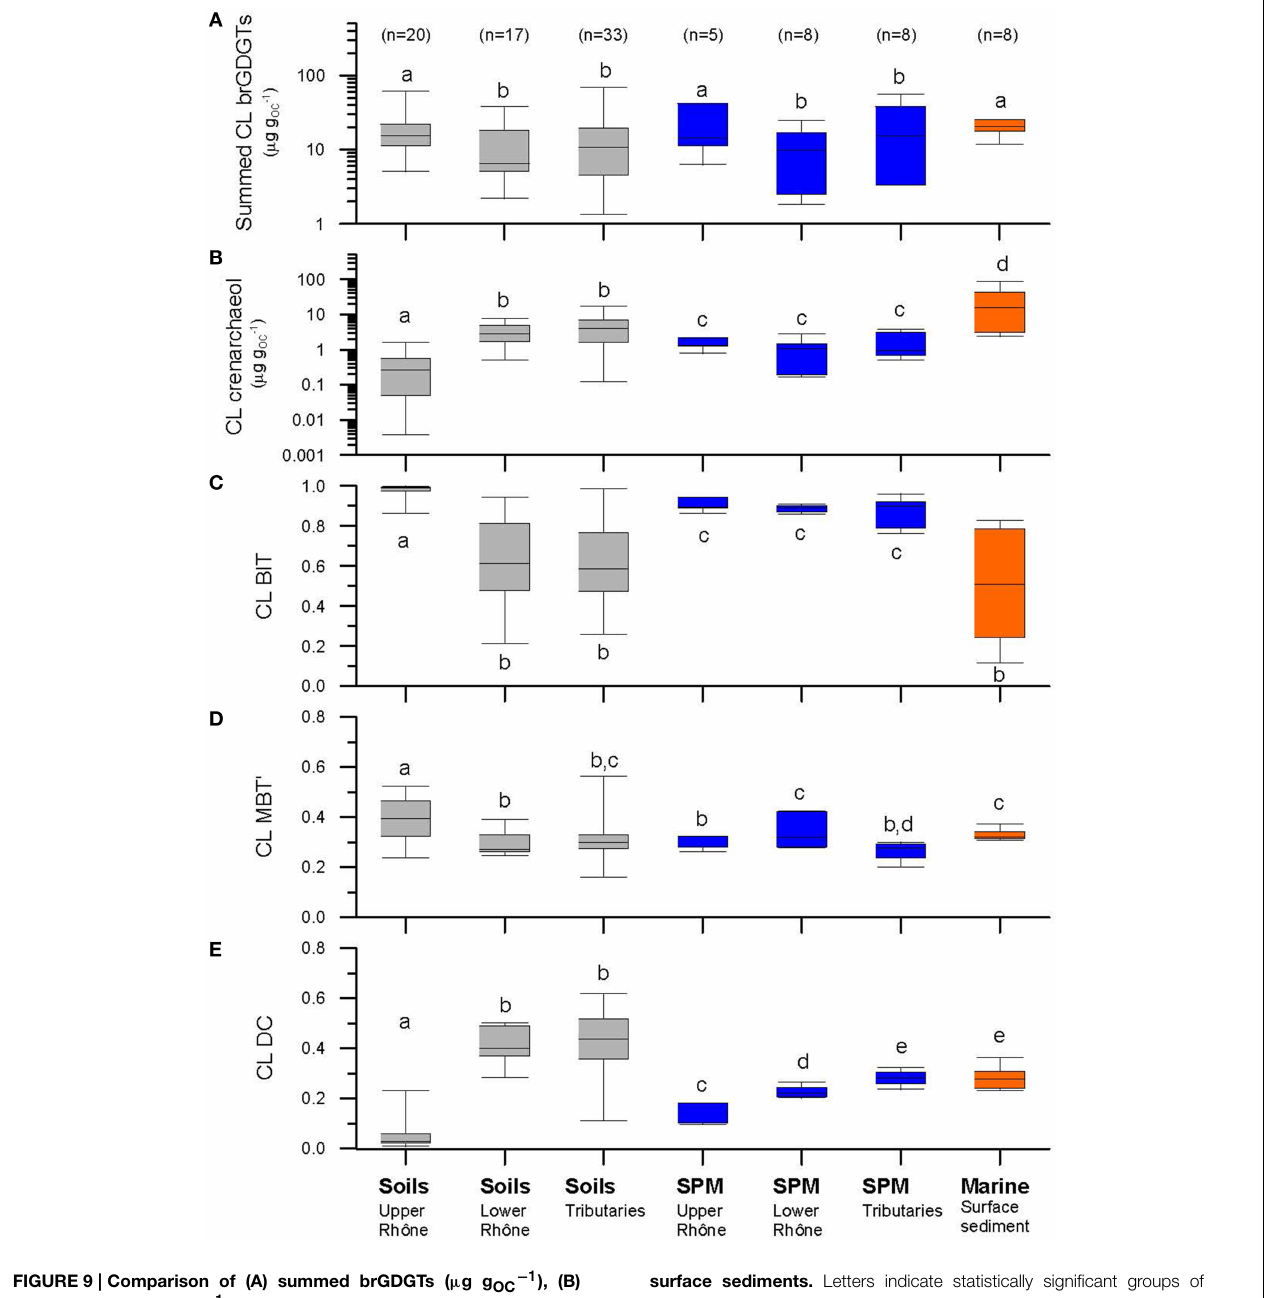
FIGURE 9 | Comparison of (A) summed brGDGTs ( µ g g OC − 1 ), (B) crenarchaeol ( µ g g OC − 1 ), (C) the BIT index, (D) the MBT’, and (E) the DC of CL fractions from soils, river SPM, and marine